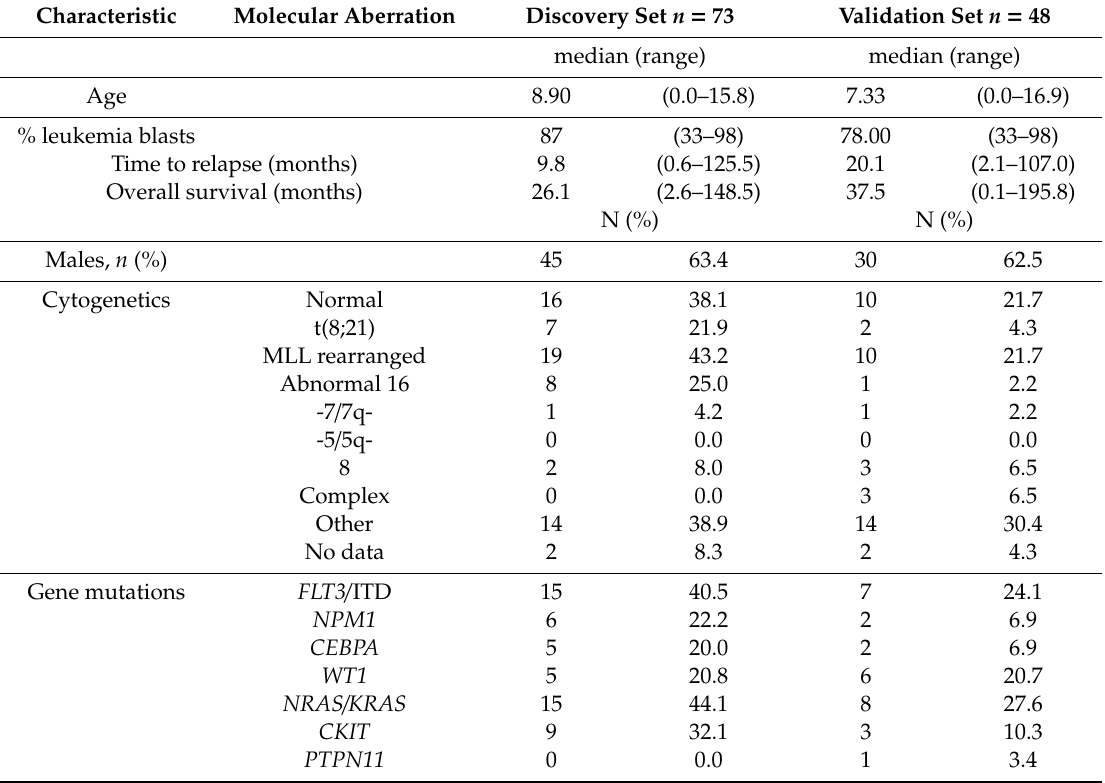
Table A1. Patient characteristics of patients from the discovery and validation cohort.